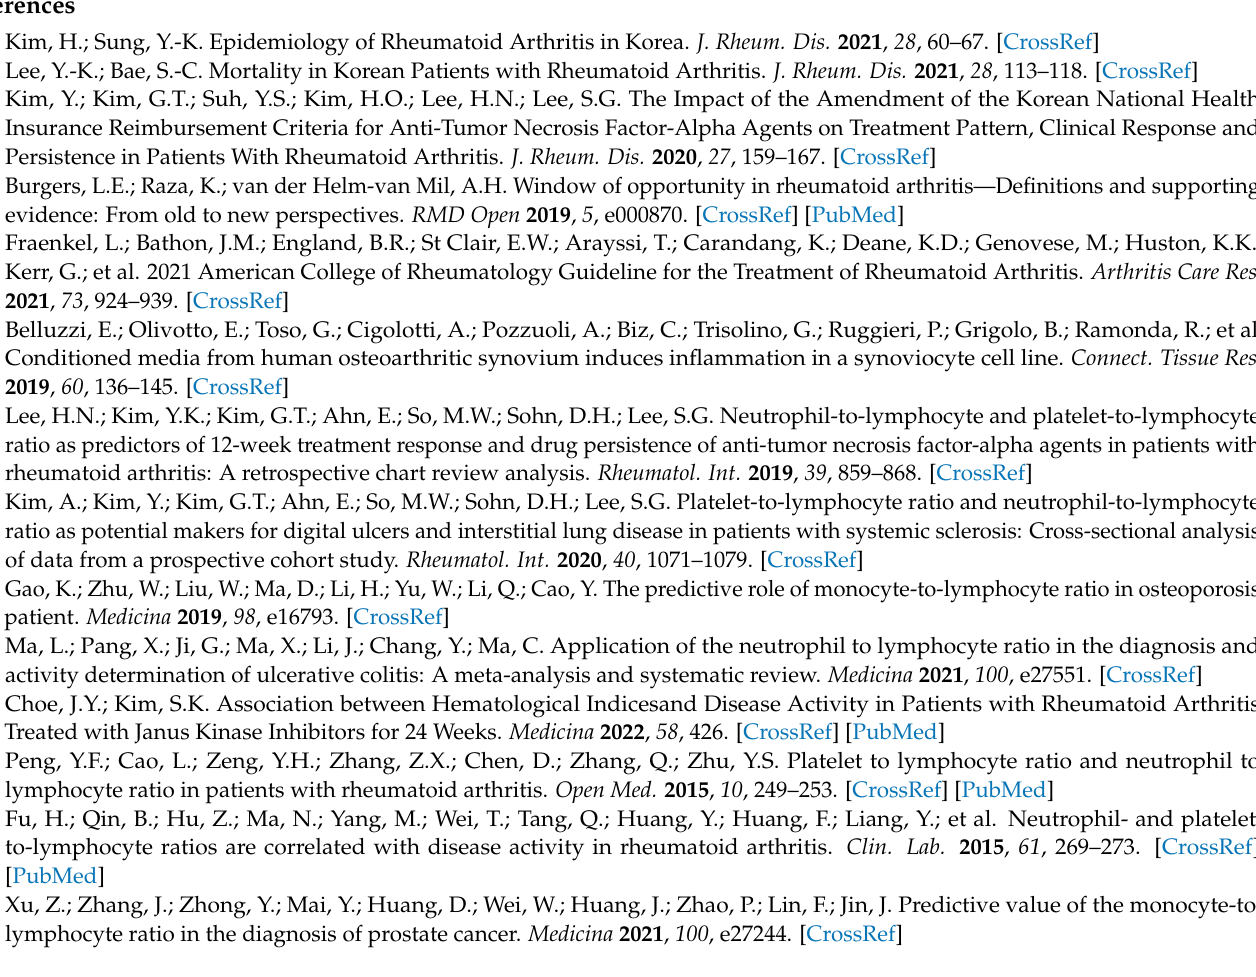
Table S3. Baseline clinical characteristics between patients with “classified rheumatoid arthritis” and “non-classified rheumatoid